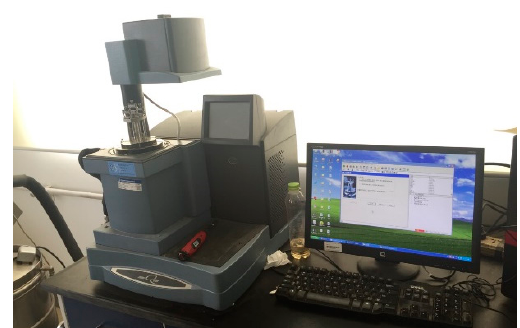
Figure 4. DMA Q800 device.